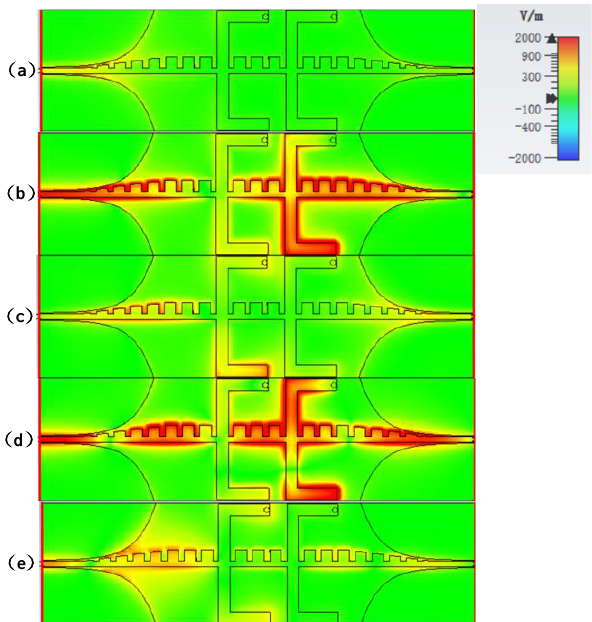
Figure 11. Simulated normalized electric field distribution: ( a ) 0.1 GHz, ( b ) 0.8 GHz, ( c ) 1.4 GHz, ( d ) 2.1 GHz, and ( e ) 2.8 GHz.